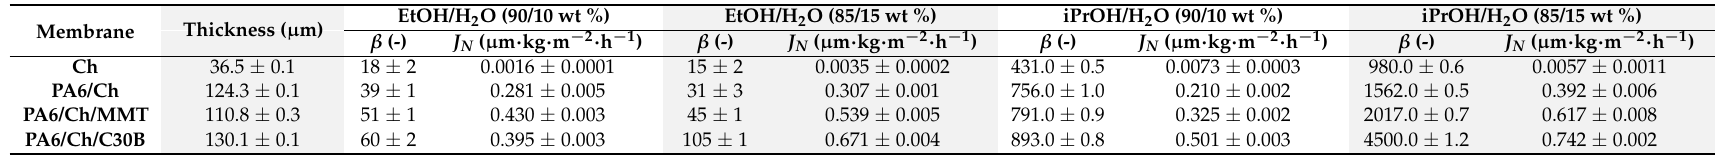
Table 5. Efficiency of homogenous and composite chitosan membranes in the separation of water-alcohol